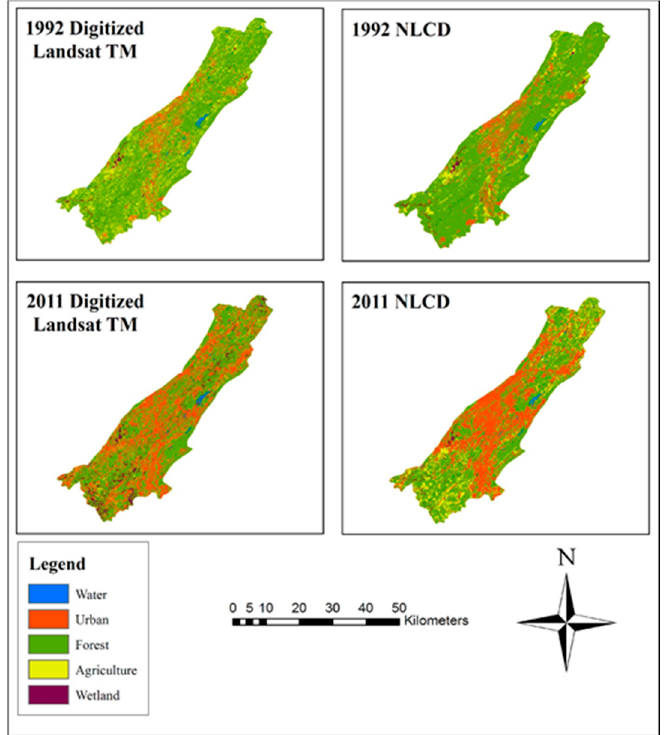
Figure 2. LULC datasets used in this study. (TM: Thematic Mapper; NLCD: National Land Cover Database).